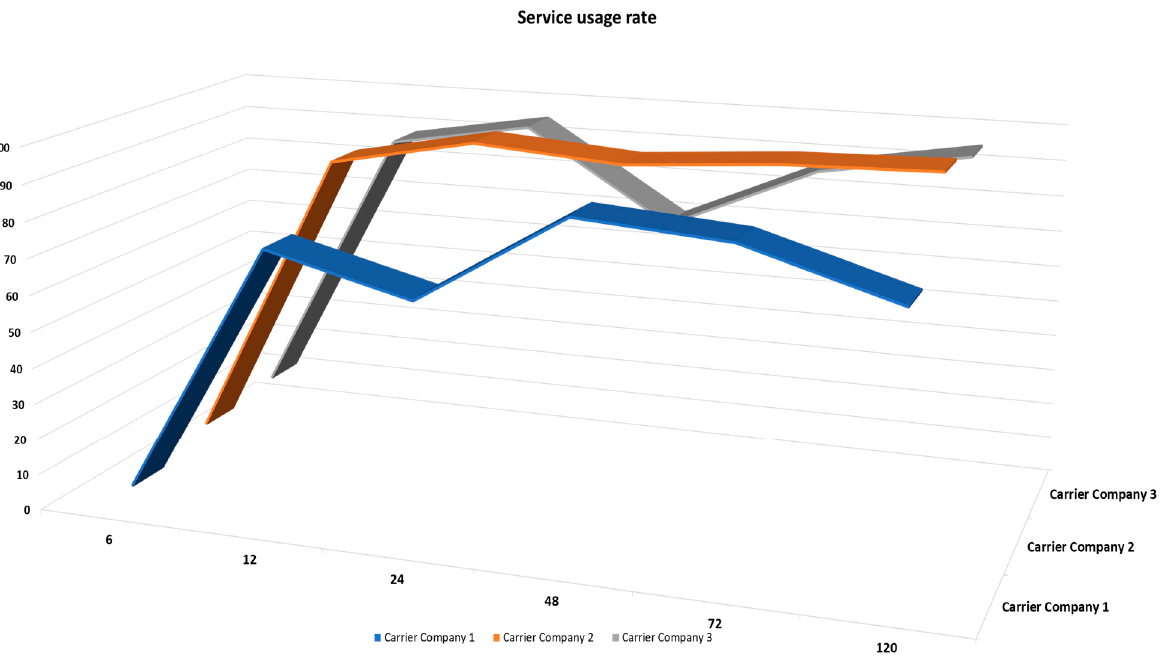
Figure 9. Service usage rate between the distribution center and manufacturers: three carriers’ com- panies